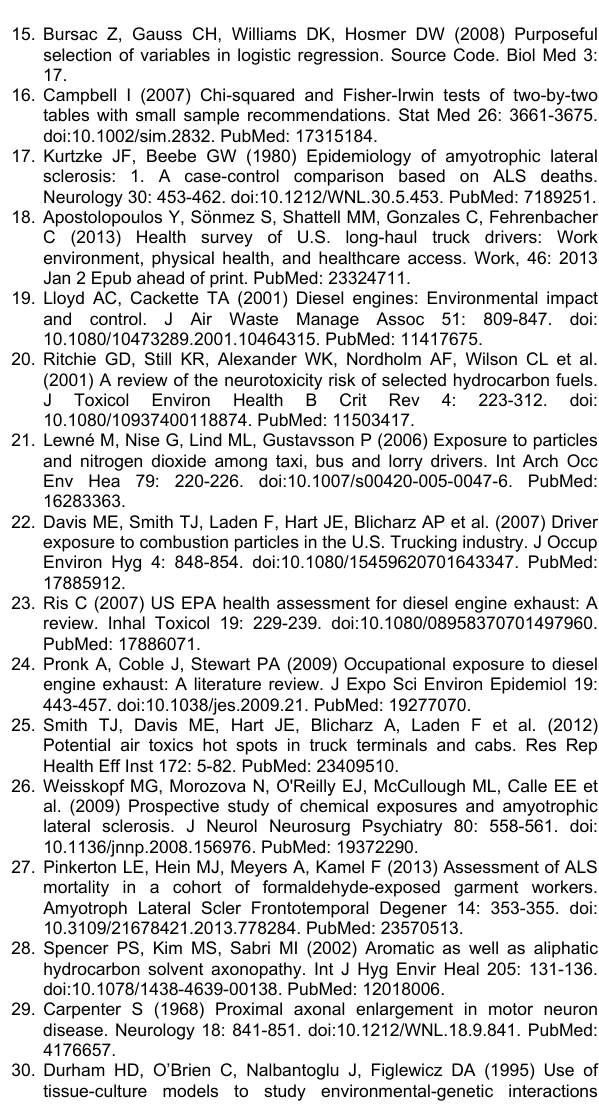
Table S2. Odds ratios, confidence intervals, and p-values for all ANZSCO and ISCO occupational titles where 5 or more SALS and control individuals were